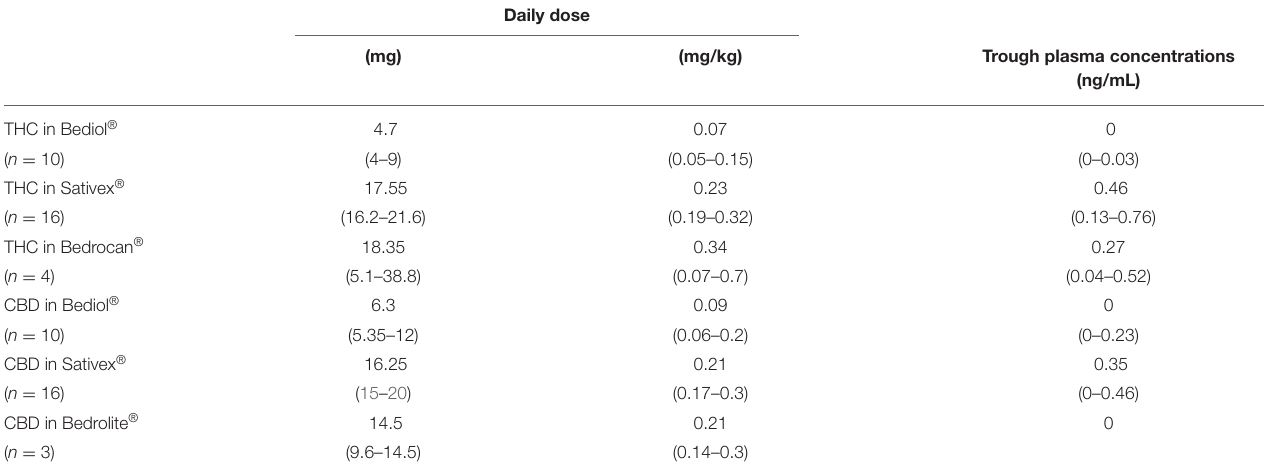
TABLE 2A | Cannabinoids daily doses and matched trough plasma concentrations by different cannabis-based oral formulations. Daily dose (mg) (mg/kg) Trough plasma concentrations